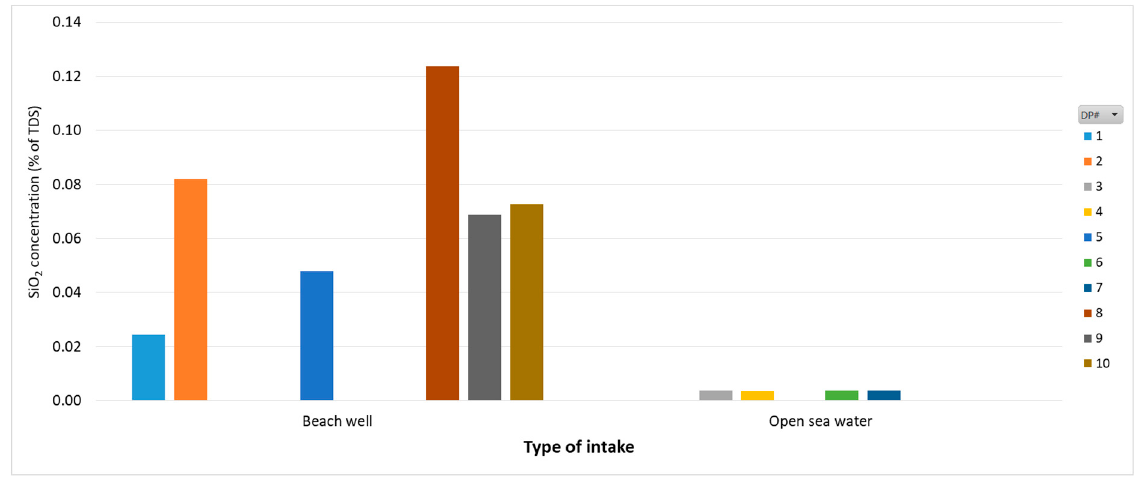
Figure 5. SiO 2 concentration in brine (as a % of TDS) per DP# by type of intake. Percentages of the sum of major ions related to TDS. Open sea water intake desalination plants produce brines with a higher percentage of the sum of major ions (>99.95%) than beach well intakes (>99.85%). Values below that level (<99.85%) may be due to